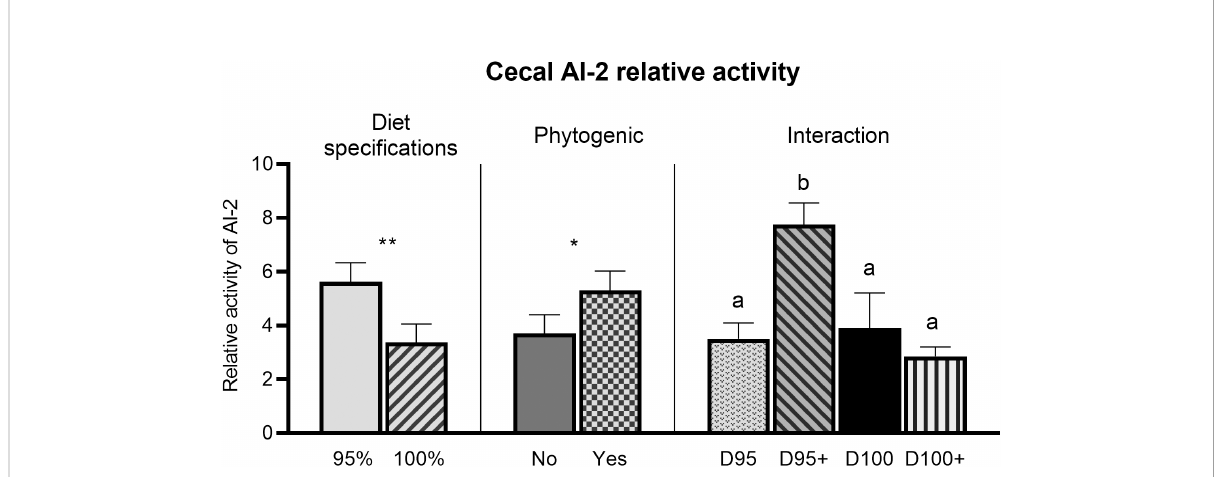
FIGURE 3 Effects of diet speci fi cations %, phytogenic inclusion, and interaction effect of diet speci fi cations × phytogenic inclusion on cecal AI-2 relative activity. Columns indicate means + SE and the asterisks denote level of statistical difference *P ≤ 0.05, **P ≤ 0.01. Treatment means with different superscripts (A, B) differ signi fi cantly (P <